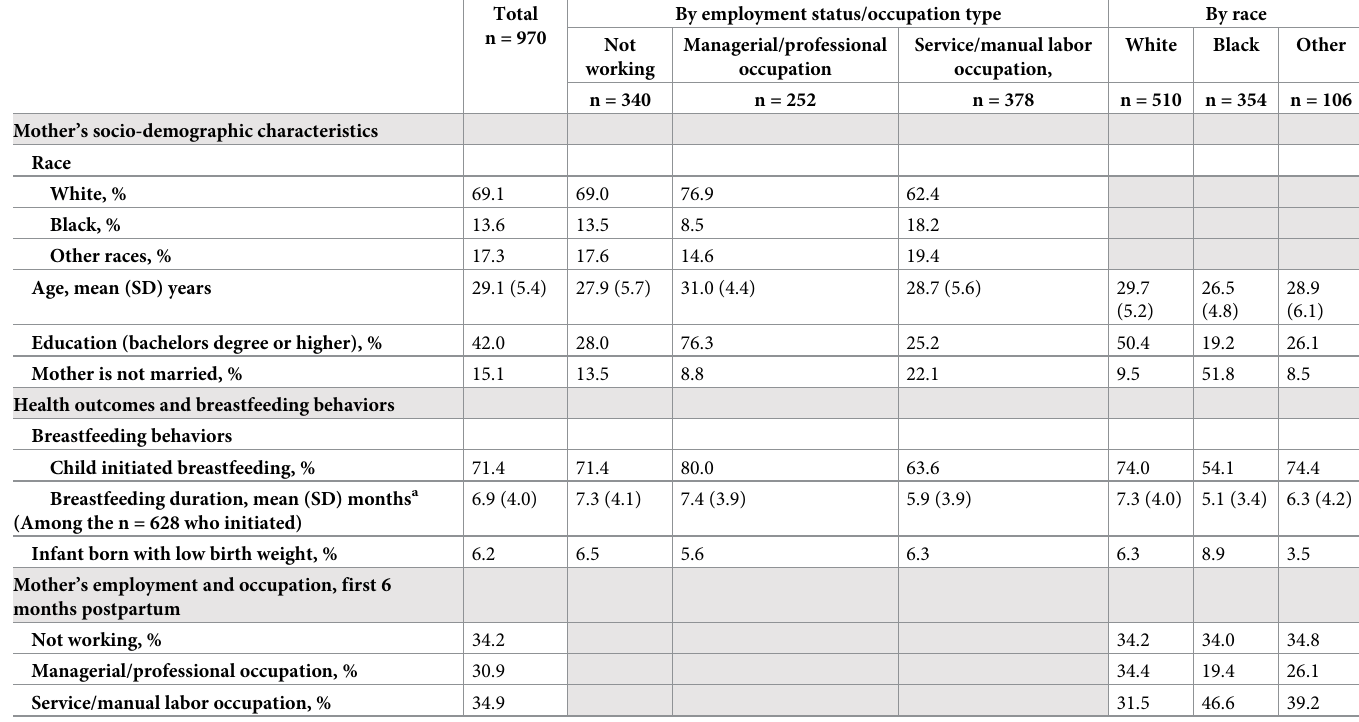
Table 1. Weighted sociodemographic characteristics, health outcomes and occupational characteristics for analytic sample of mothers and